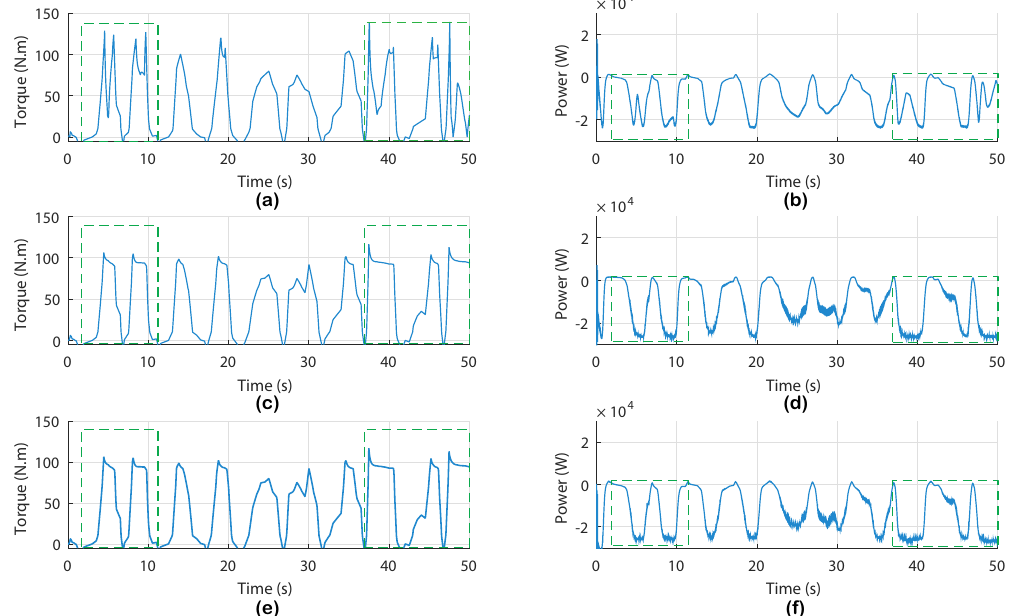
Figure 20. OWC torque and power outputs with real wave data input. ( a ) Torque in the uncontrolled case. ( b ) Power in the uncontrolled case. ( c ) Torque with ZN-PID. ( d ) Power with ZN-PID. ( e ) Torque with SGHS-PID. ( f ) Power with